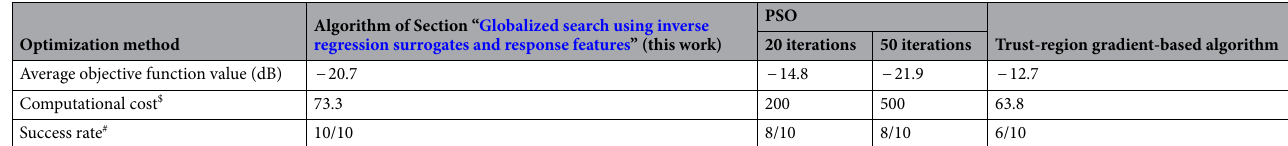
Algorithm of Section “Globalized search using inverse regression surrogates and response features” (this work)